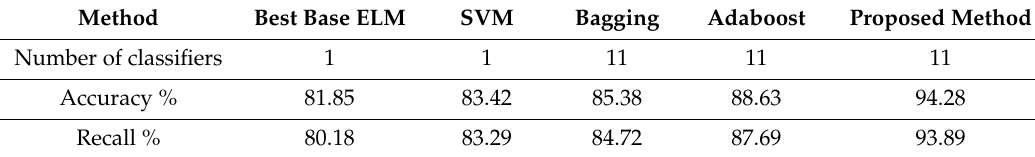
Table 9. Recognition performance comparison of different methods.